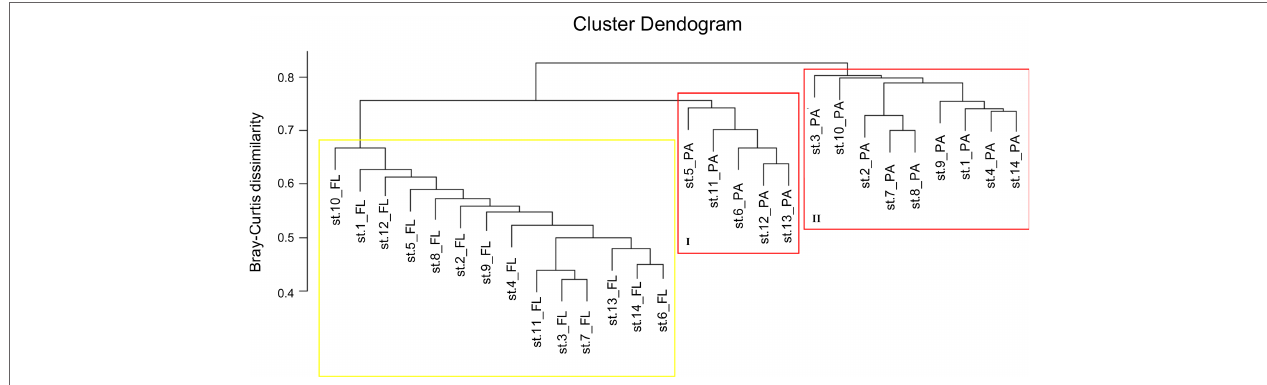
FIGURE 4 | Hierarchical clustering based on a Bray–Curtis dissimilarity matrix. The yellow square delimitates FL communities. The red squares delimitate PA prokaryotic